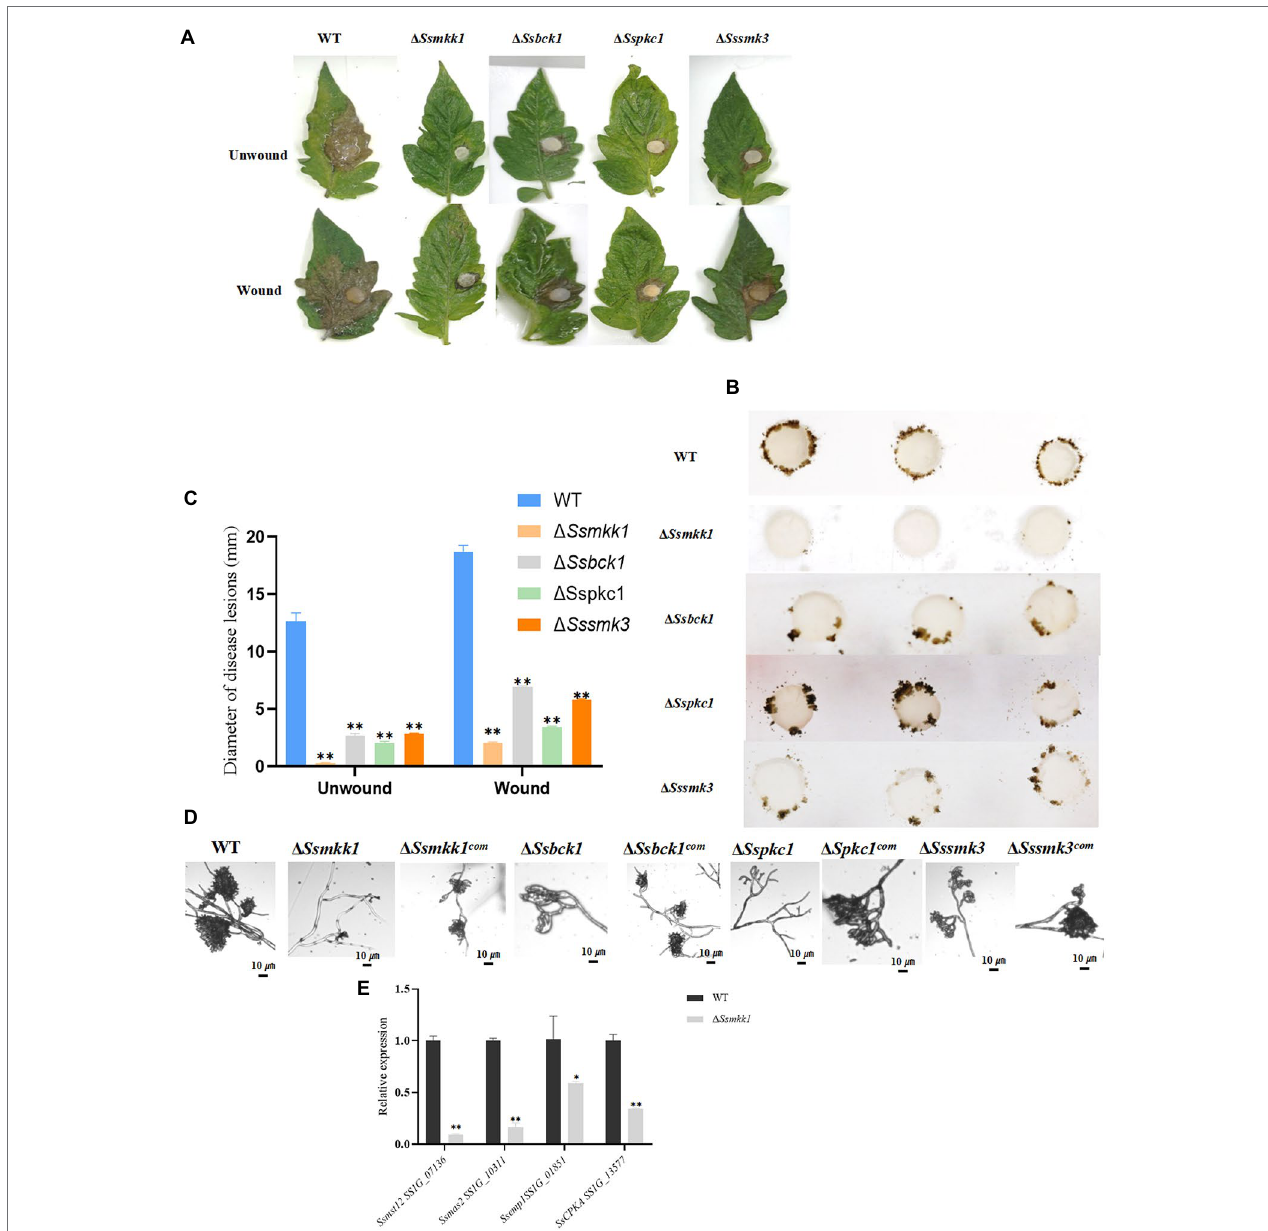
FIGURE 6 | (A) WT, Δ Ssmkk1 , Δ Sspkc1 , Δ Ssbck1 , and Δ Sssmk3 strains were inoculated on unwounded and wounded common tomato leaves and photographed 2 DAI after inoculation. (B) Compound appressorium development of WT, Δ Ssmkk1 , Δ Sspkc1 , Δ Ssbck1 , and Δ Sssmk3 strains on glass